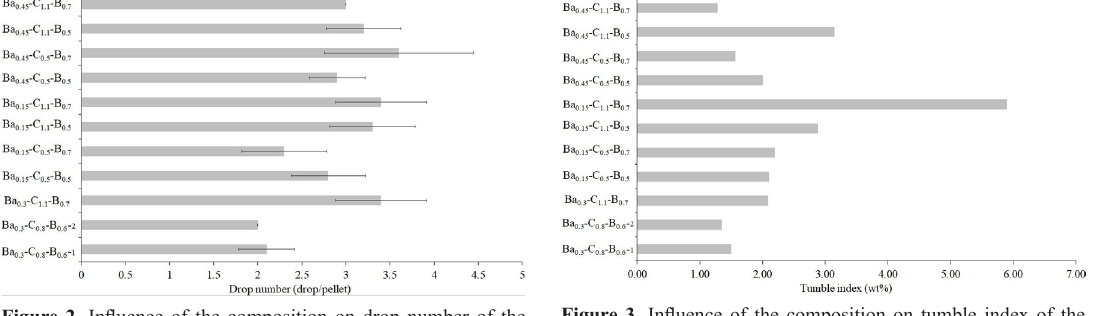
Figure 2. Influence of the composition on drop number of the green iron-ore pellets.